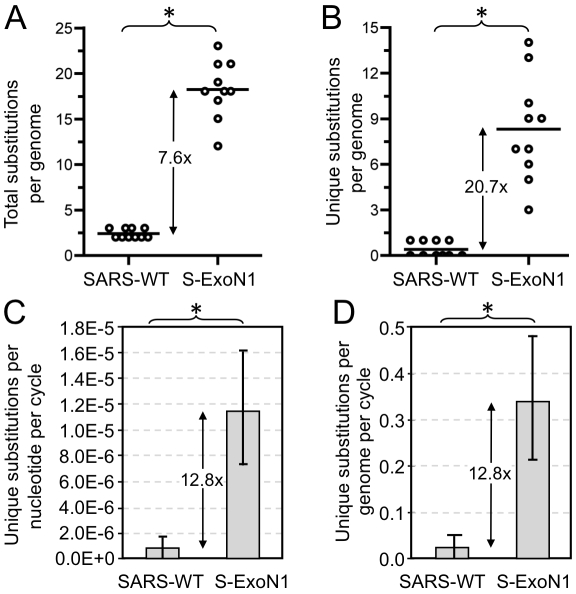
Mutation counts and rates in viral clones.Complete genome sequences were determined for 10 SARS-WT and 10 S-ExoN1 P3 viral clones. Numbers of total (A) or unique (B) non-engineered nucleotide substitutions identified in SARS-WT and S-ExoN1 genomes are indicated. Each circle represents the mutation count value from a single genome sequence and lines indicate mean mutation counts. Rates of accumulation of unique substitutions per replication cycle on a per nucleotide (C) or per genome (D) basis. Mean values are plotted and error bars indicate standard deviations. *, P<0.0005; Wilcoxon rank-sum test.